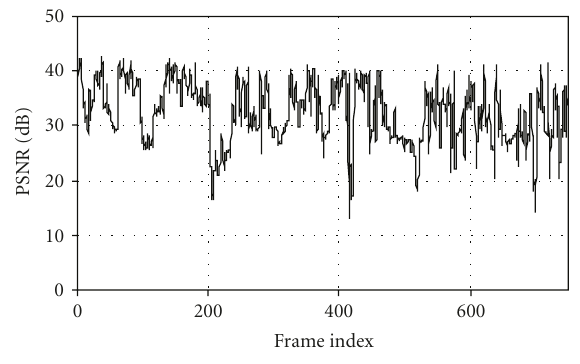
Figure 18: PSNR over the 750 frames, showing a falling trend in PSNR over time, for the power-aware FLC ARQ with DAB.